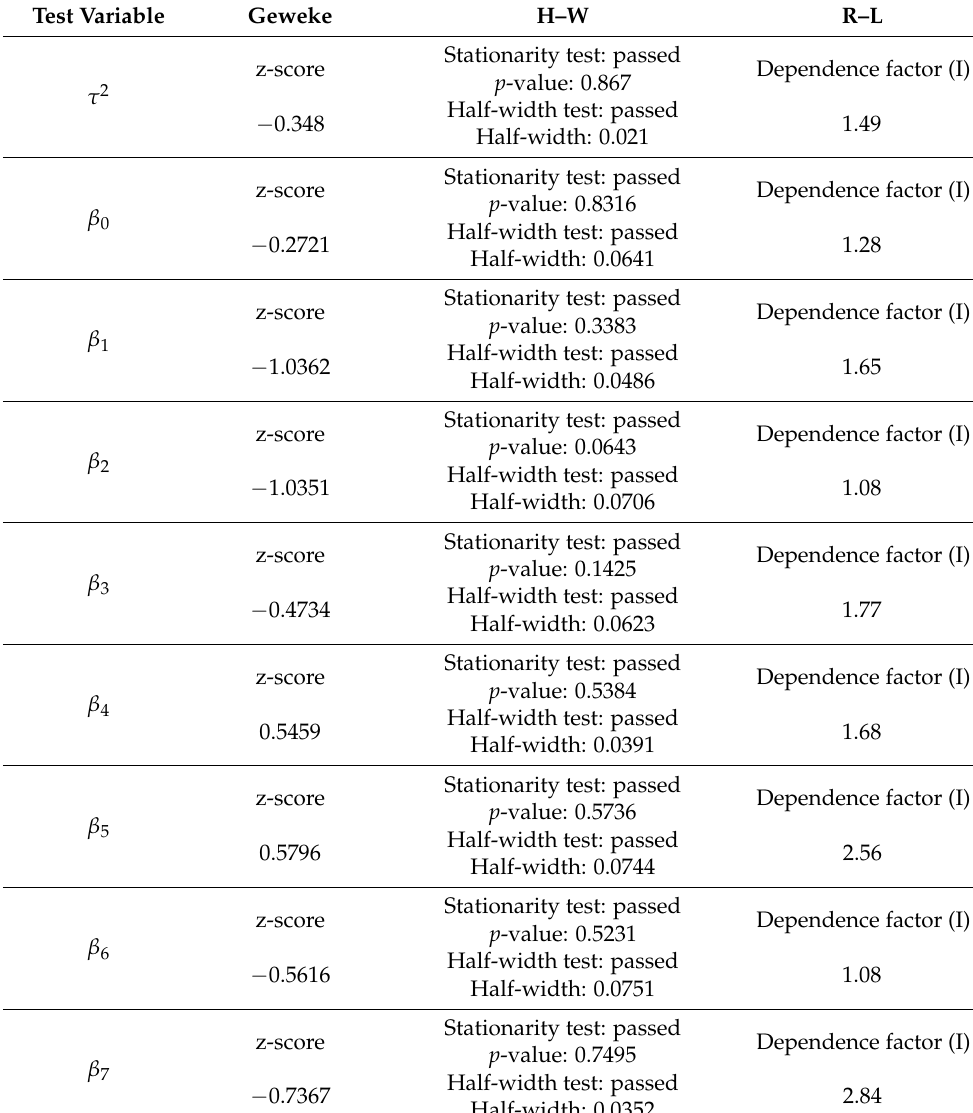
Table 2. The MCMC convergence diagnostics for τ 2 , β 0 , . . . , β 7 using the Geweke, H–W, and R–L tests (the simulated effect